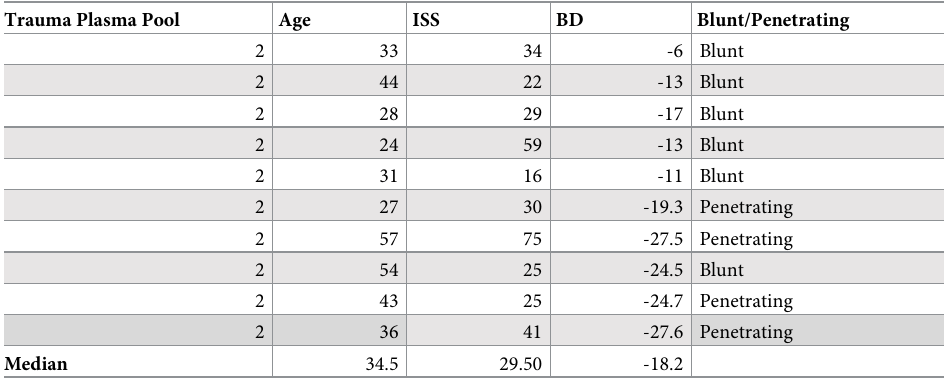
severity score (ISS), and base deficit (BD). ISS is used to determine the extent of injury severity, and BD is used to determine tissue hypoperfusion [20–22]. Severe injury is any sample from a patient with an ISS > 15 and BD < -6. Table 2. Trauma plasma pool used for ELISA.